Question: Write a descriptive caption for this figure.
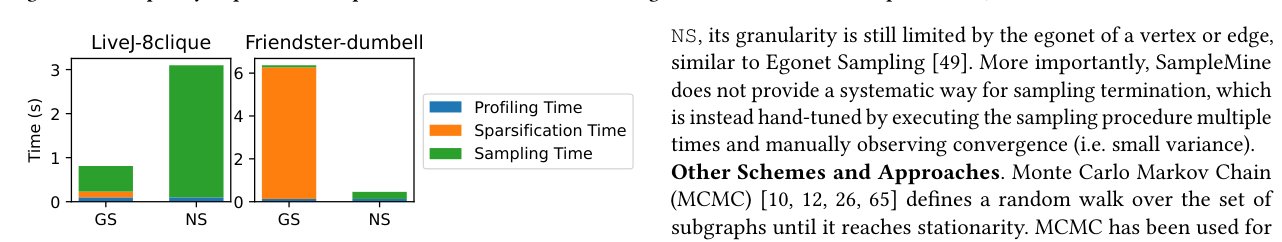
Answer: End-to-end time breakdown of ScaleGPM.